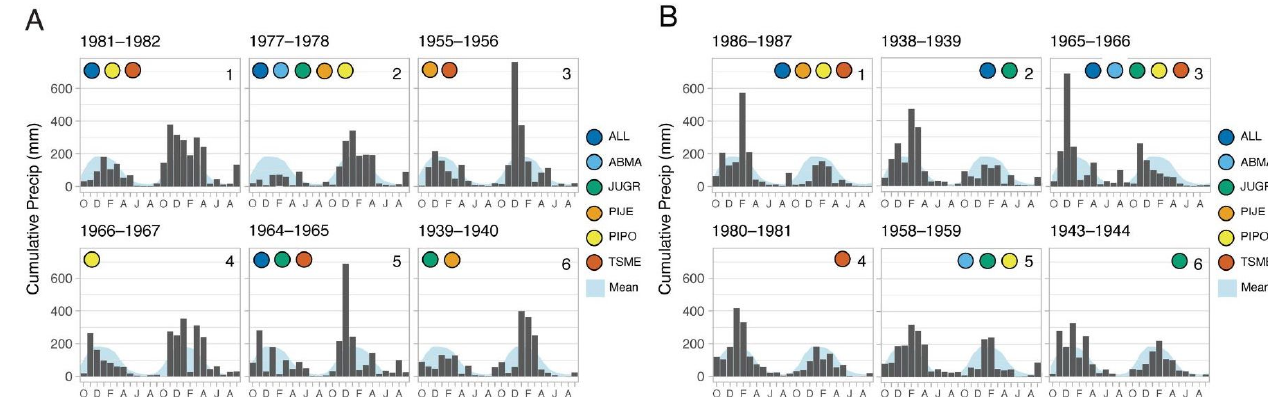
Figure 5. Monthly P12 precipitation in years of whiplash events in P12. ( A ) Positive events. ( B ) Neg- ative events. Events are ordered by severity ranking (number at upper right). Background shading shows long-term mean monthly precipitation, which does not vary among frames. The colored dots indicate species-specific reconstructions with events in same years.